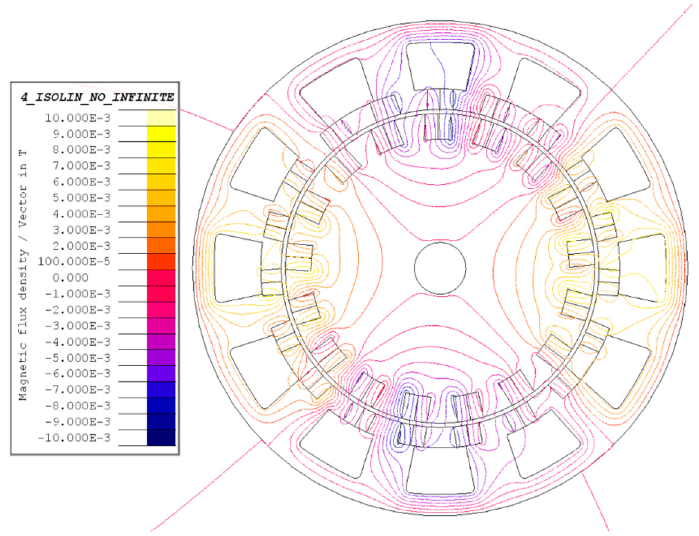
Figure 9. Final DPMM design with mesh distribution.